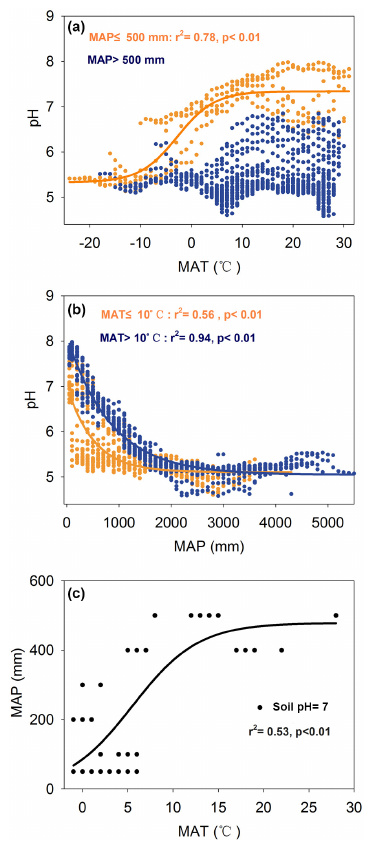
Figure 5. Changes in surface (0–30cm) soil pH with climate. (a) Mean annual temperature (MAT); (b) mean annual precipitation (MAP), and (c) changes in “critical MAP” at soil pH = 7.0 with MAT. Here critical MAP means the corresponding MAP at a soil pH of = 7.0, which indicates a shift from alkaline to acidic soil. We used MAP of 500mm as a threshold of transition from arid to humid climate and MAT of 10 ◦ C as a threshold of transition from cool to warm climate. (Table 1). Mean soil C : N ratio showed the highest values in tundra and boreal forest ( > 15 : 1), while it was lowest in desert, temperate shrubs and grasslands ( ≤ 10 : 1) (Ta- ble 1; Fig. 3h). On average, the global means of SOC den- sity and STN density were 6.94 (SD = 4.42) kg C m − 2